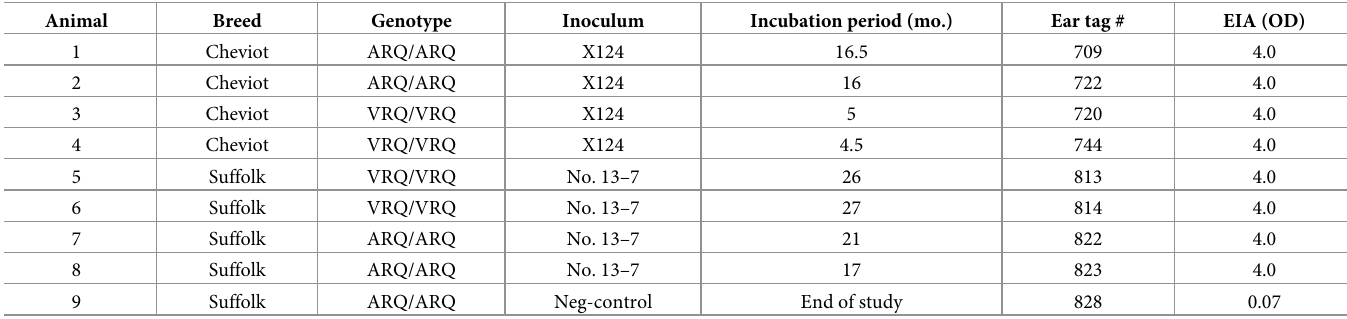
Table 1. Clinical information for sheep samples.